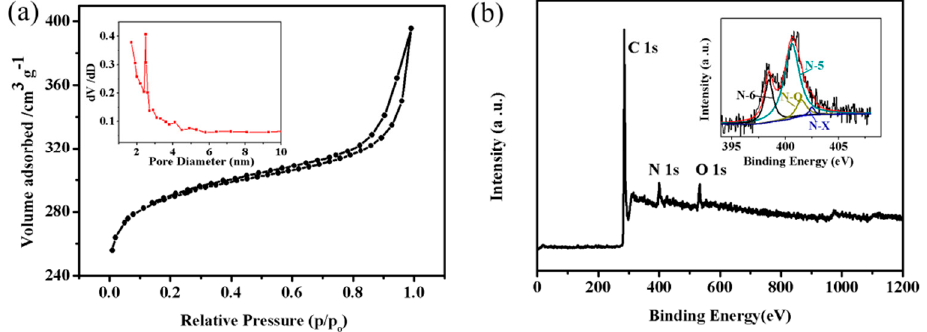
Figure 6. ( a ) N 2 adsorption/desorption isotherm of NCFs and inset pore-size distribution curve; ( b ) XPS survey spectrum of NCFs and inset N 1 s high resolution spectra.